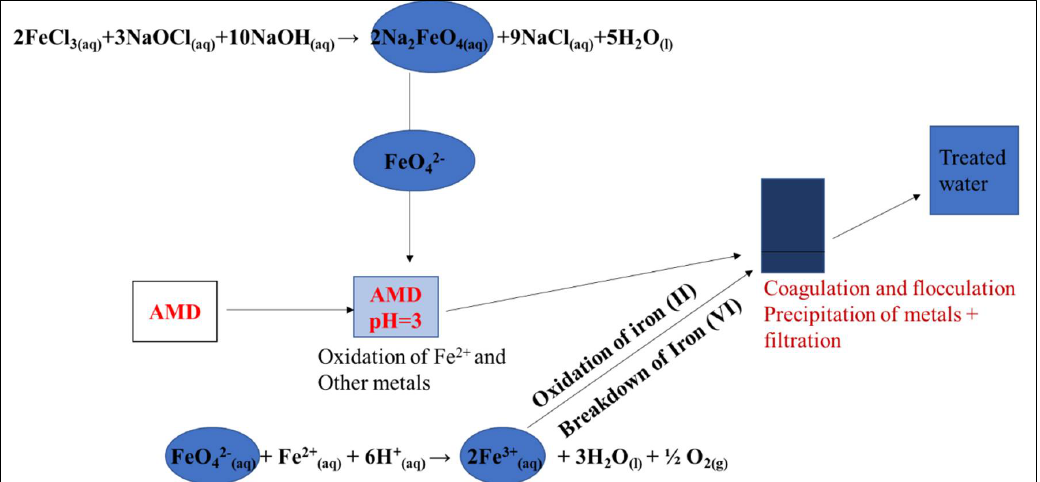
Figure 6. Process flow diagram of AMD treatment (oxidation and chemical desalination).